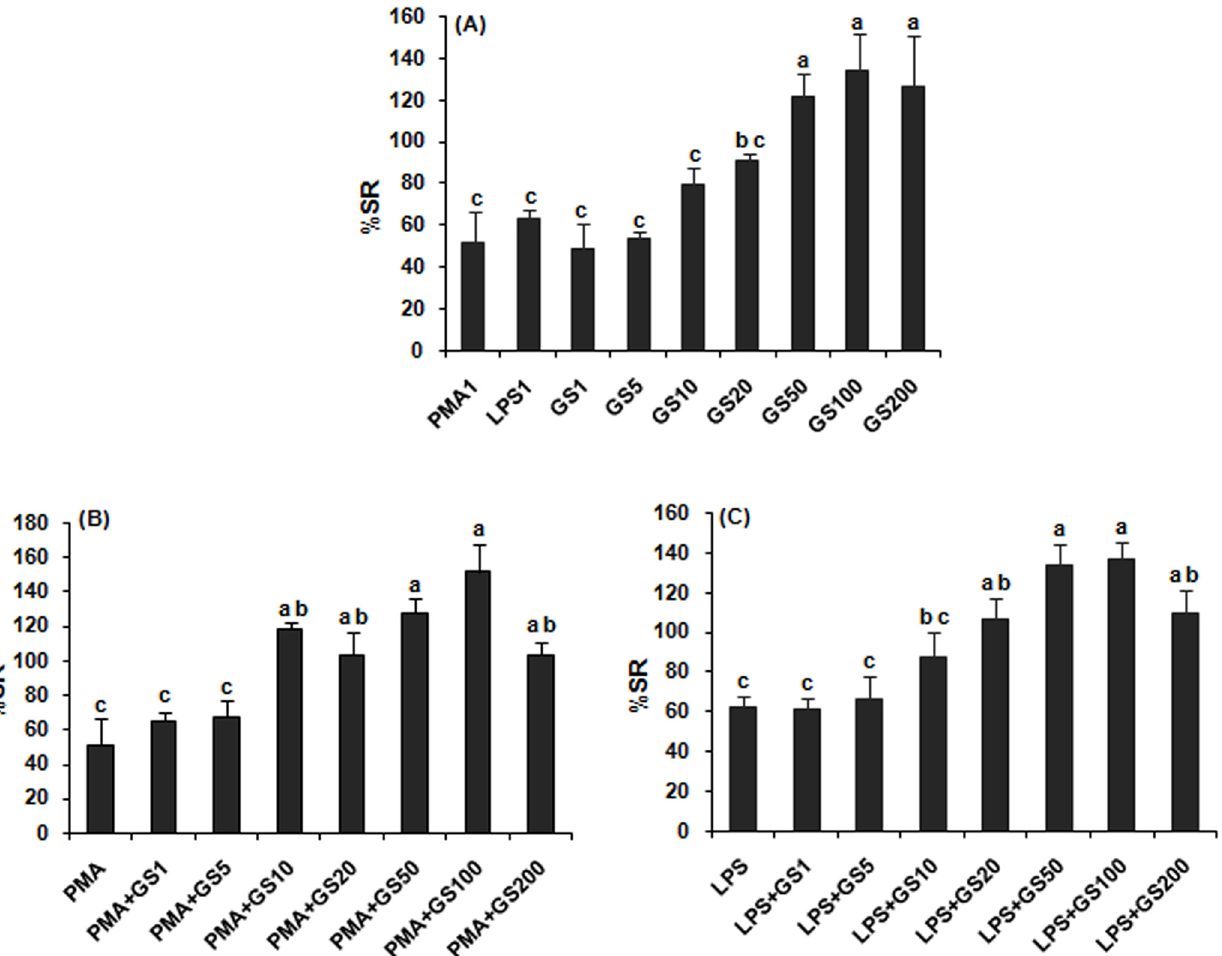
Fig 2. Nitrite release in rat peritoneal macrophages in vitro treated with Gymnema sylvestre leaf extract alone (A) and in combination with PMA 1 μ g/ml (B) and LPS 1 μ g/ml (C). GS1 – GS200 represent concentration of extract, 1 – 200 μ g/ml, respectively. Bars bearing same alphabet do not differ significantly. [Treatment effect ANOVA: (A) F = 7.10 (8, 18); p < 0.05, (B) F = 5.05 (7, 16); p < 0.05, (C) F = 10.29 (7, 16); p <